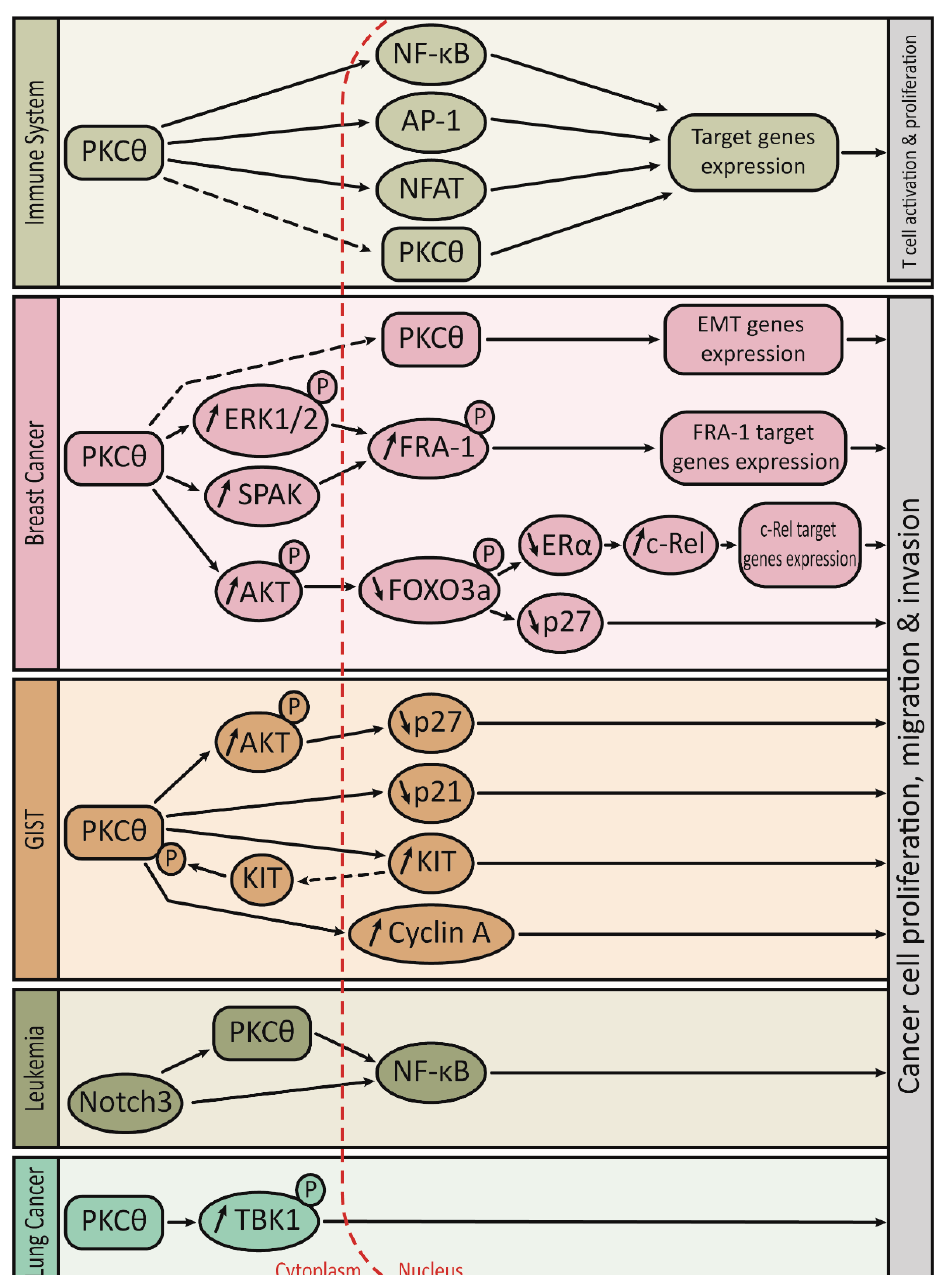
Figure 2. Cartoon summarizing the PKC θ -mediated signaling pathways controlling the immune response and the tumor aggressiveness.